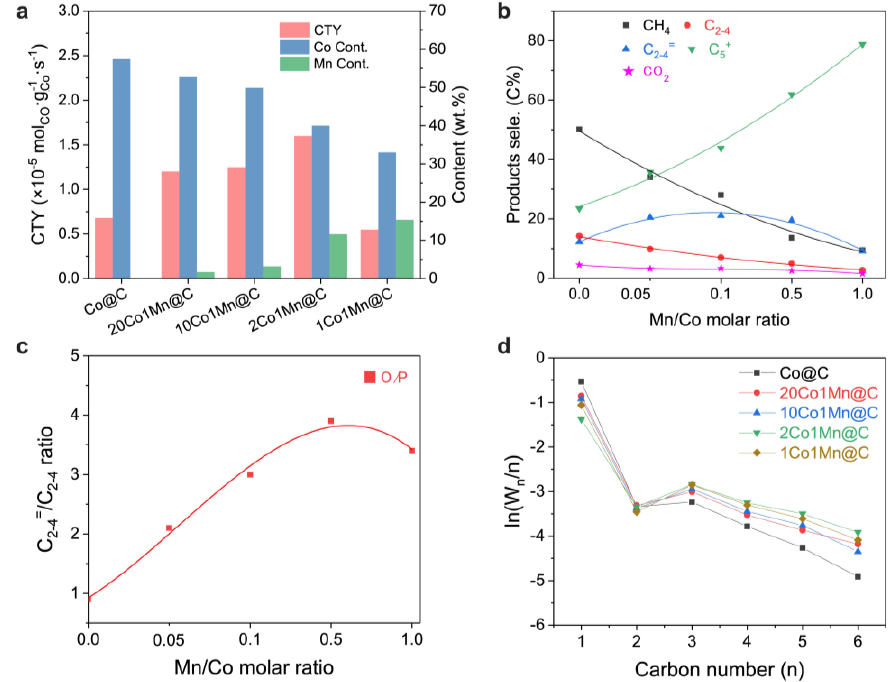
Figure 1. ( a ) Cobalt time yield (CTY) and content of Co, Mn measured by ICP-MS; ( b ) product se- lectivity; ( c ) C 2 -C 4 olefin/paraffin ratio (O/P) as a function of Mn/Co molar ratio, and ( d ) ln(Wn/n) obtained by the catalysts at 235 ℃ under 1 bar with CO conversion limited to ~20% by adjusting the space velocity. Here, the GHSV = 5000 mL ‧ g cat −1 ‧ h −1 for Co@C, GHSV = 8000 mL ‧ g cat −1 ‧ h −1 for 20Co1Mn@C, 10Co1Mn@C, and 2Co1Mn@C, GHSV = 2400 mL ‧ g cat −1 ‧ h −1 for